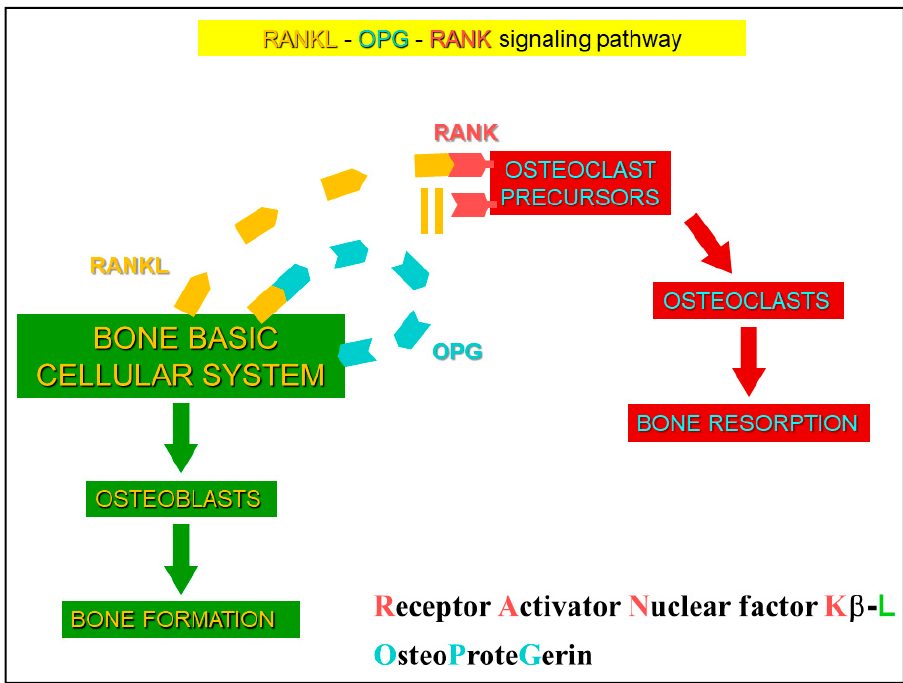
Figure 12. Scheme of RANK/RANKL/OPG system. Under specific conditions, differential RANKL and OPG production are induced, and the dynamic RANKL/OPG ratio leads to either bone formation or bone resorption.